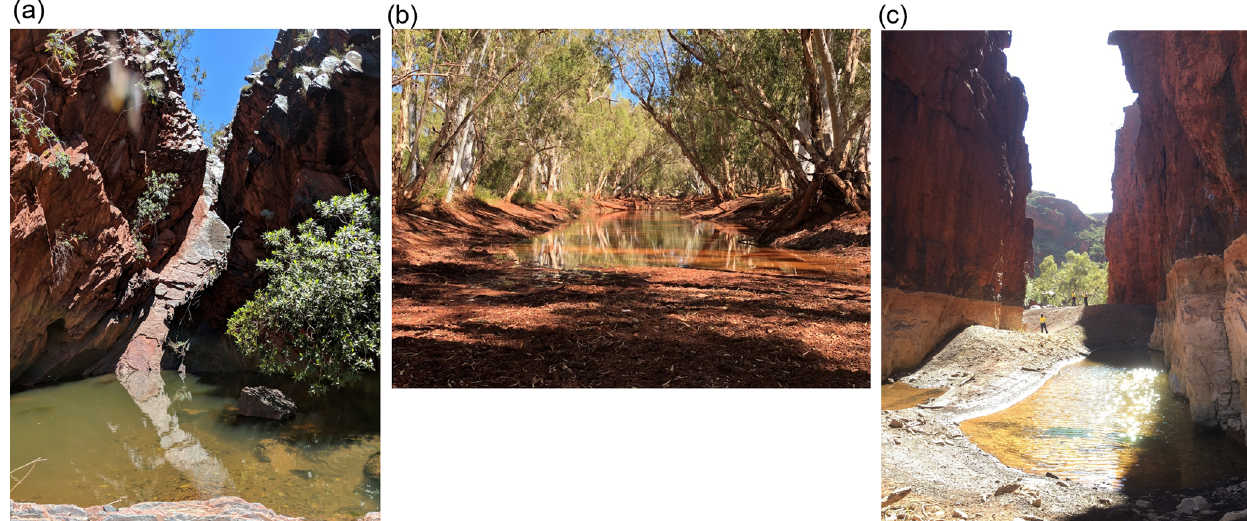
Figure 8. Photos demonstrating presence or absence of alluvium indicating (a) no alluvium and perched surface water, (b) extensive alluvium and pool supported by throughflow of alluvial groundwater, and (c) alluvium within shaded gorge so that persistence of water sourced from outflow of alluvial groundwater is